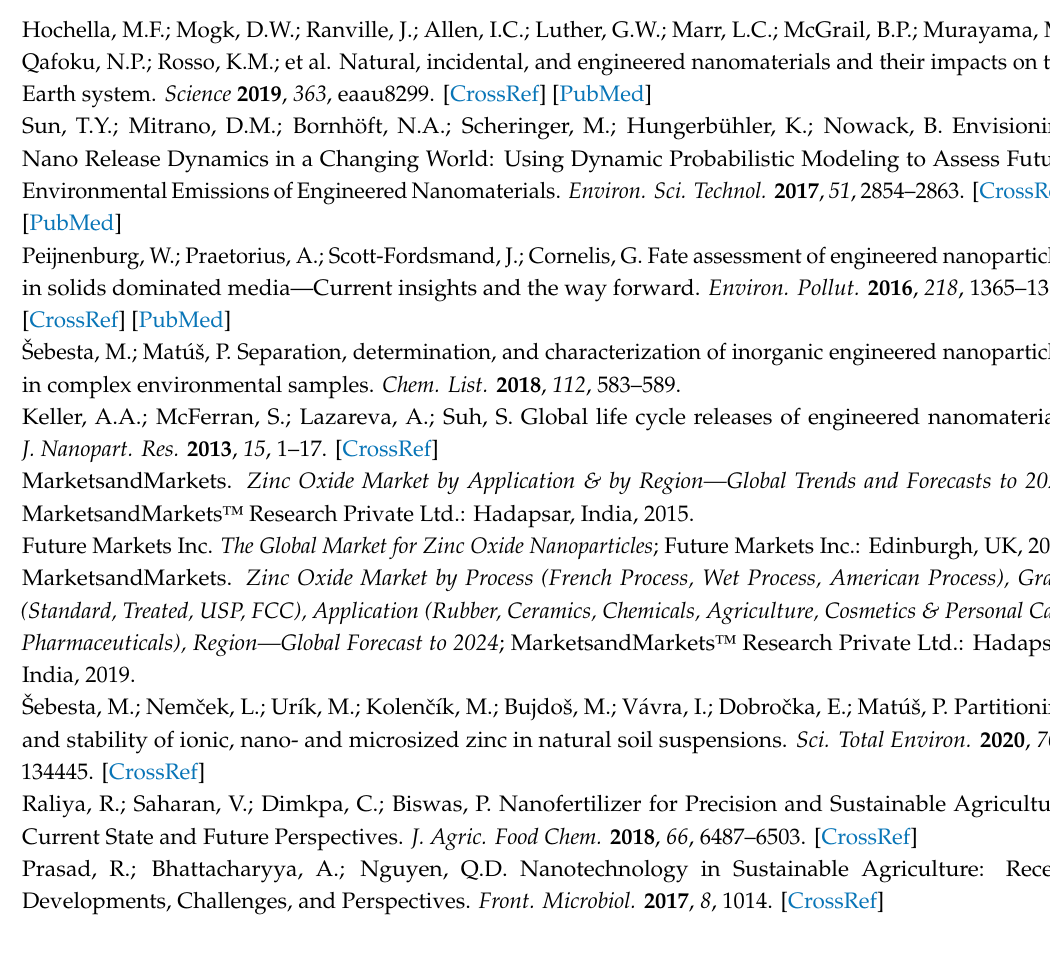
Figure S1: Photographs of Aspergillus niger mycelia after 7-day cultivation in the preliminary test, Table S1: Weight of dry biomass after 7-day static cultivation in the preliminary